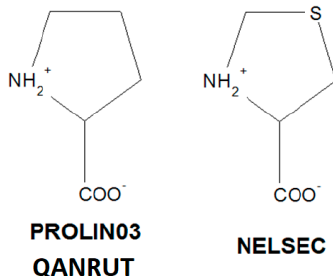
Figure 1. Neutral, zwitterionic, cationic and anionic forms of proline moieties as identified in 2366 relevant structures retrieved from the Cambridge Structure Database (CSD) ([157]; CSD, ver. 5.41,